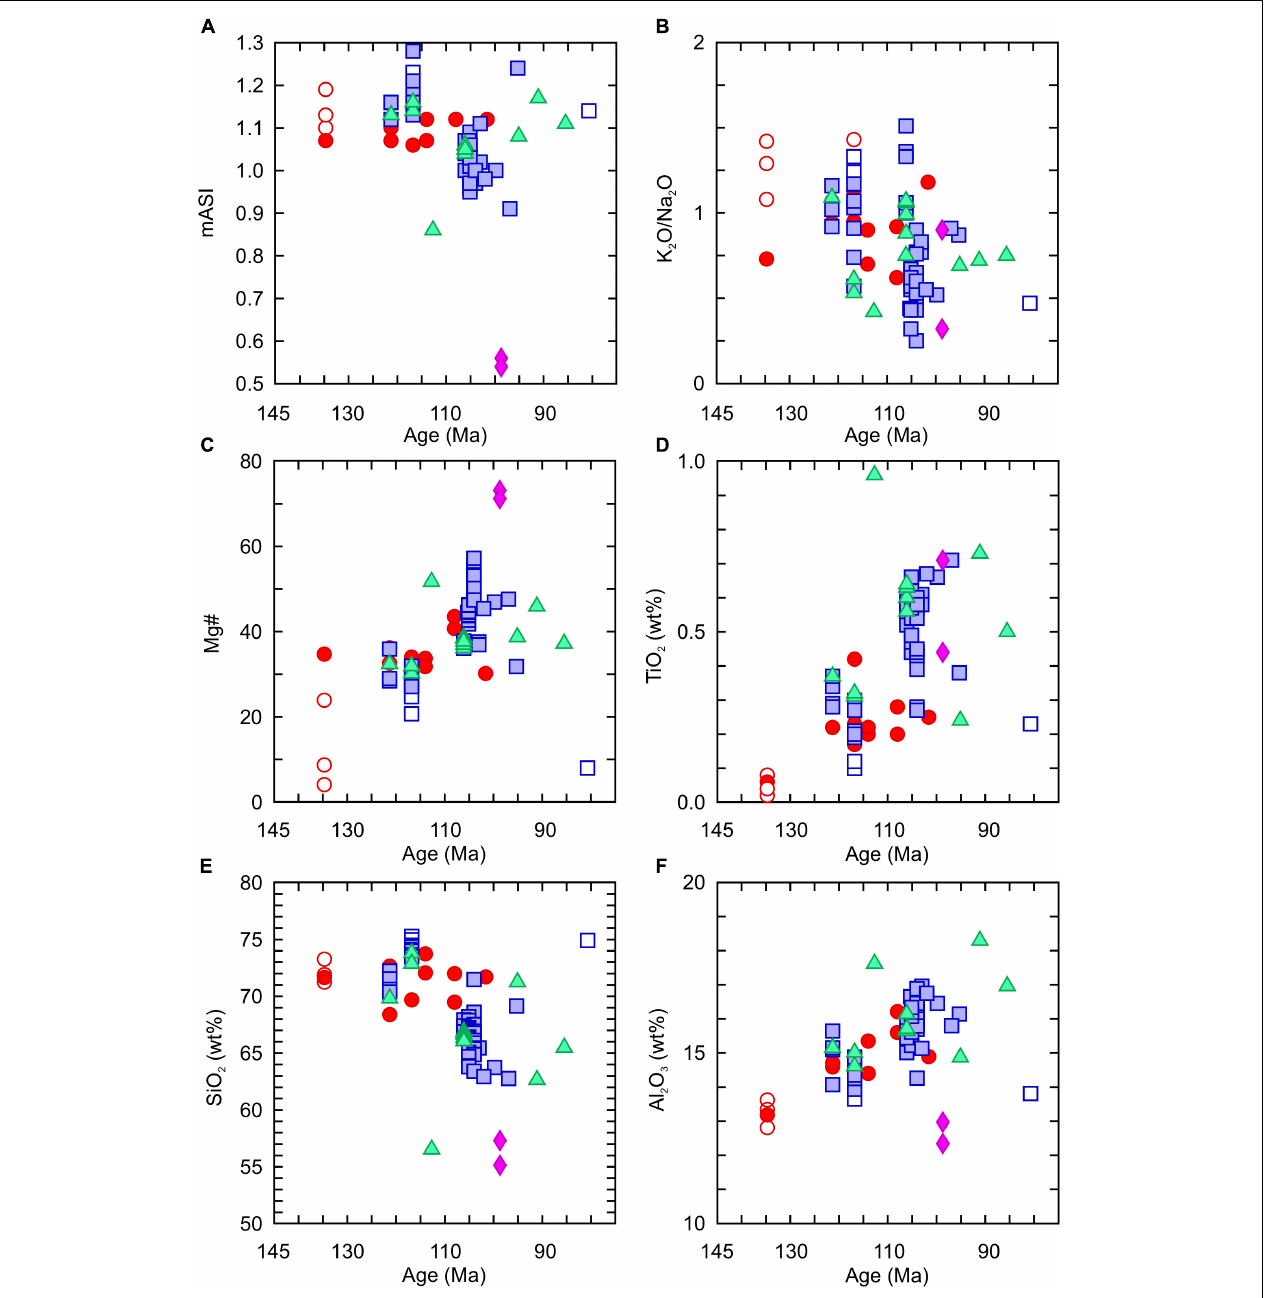
FIGURE 8 | Major element secular variability of the Cretaceous granitic (granties, granodiorites, tonalites, diorites) rocks from Kyushu. (A) mASI [molecular Al/(Ca − 1.67P + Na + K)], (B) K 2 O/Na 2 O, (C) Mg# [molecular Mg/(Mg + Fe)*100], (D) TiO 2 (wt%), (E) SiO 2 (wt%), and (F) Al 2 O 3 (wt%). Symbols as in Figure 2 .